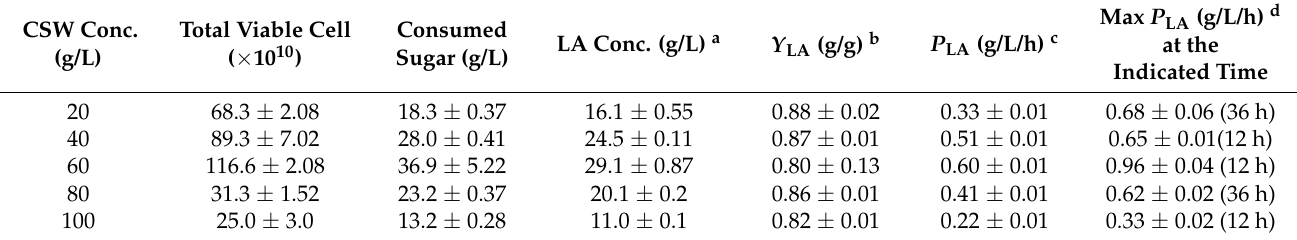
Table 5. Effect of different concentrations of CSW on the growth, sugar consumption, LA concentration, LA yield, LA productivity, and maximum LA productivity by E. faecium WH51-1. CSW Conc.